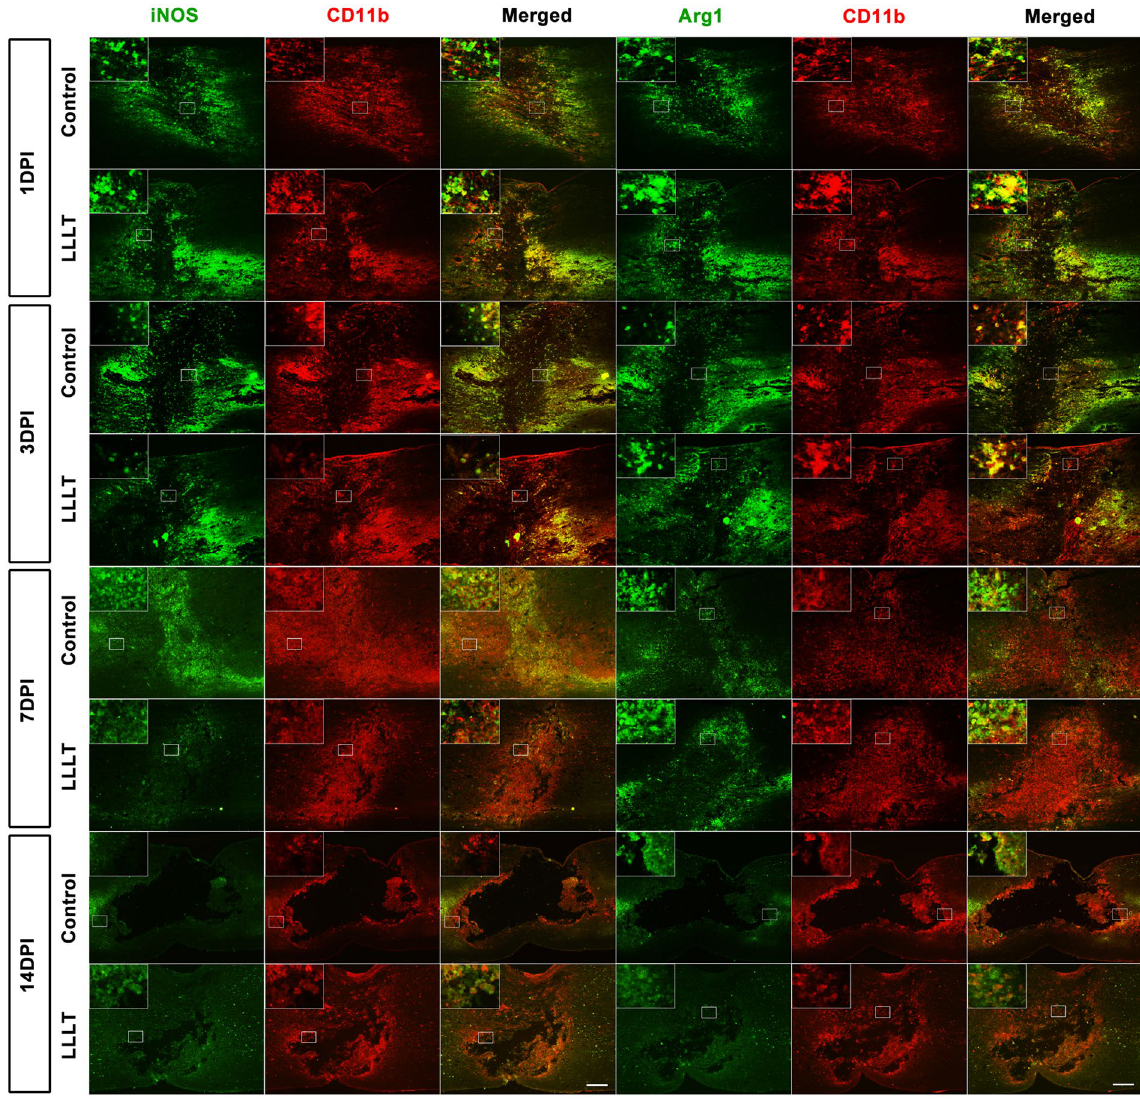
Figure 1. Time course of macrophage/microglia polarization. iNOS + CD11b + cells refer to a M1 phenotype, Arg1 + CD11b + cells refer to a M2 phenotype. Positive cells in the merged panels exhibit a yellow signal. The corner pictures are enlarged images of the small frame in each panel. Bar = 200 μ m. iNOS, inducible nitric oxide synthase; Arg1, arginase 1. 1 dpi, 3 dpi, 7 dpi, and 14 dpi refer to 1, 3, 7, and 14 days post-injury,